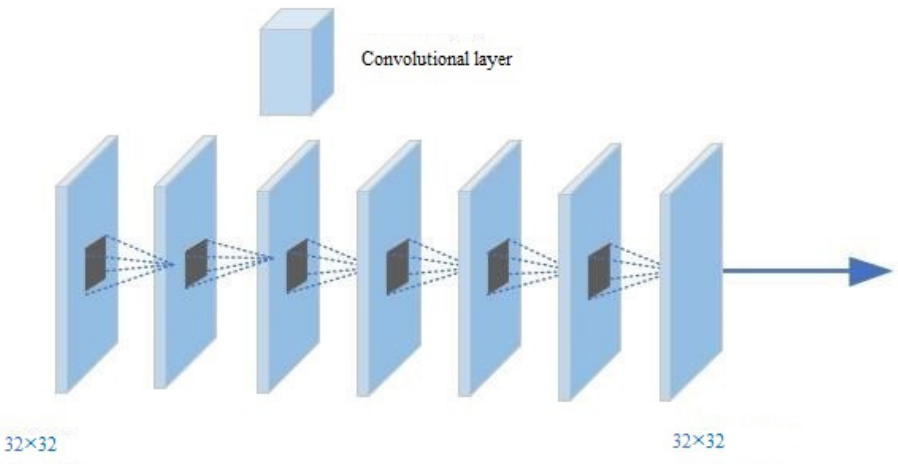
Figure 10. Fully convolutional network without pooling layers.